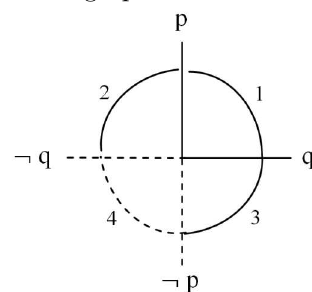
Table 3: Truth-table of disjunctive Graph 3: Truth-graph of disjunctive expression expression